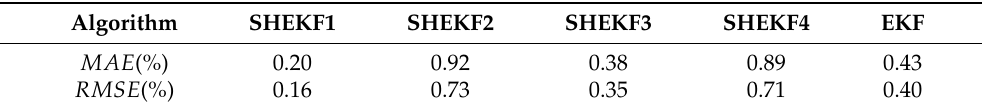
Table 3. RMSE and MAE with correct initial SOC